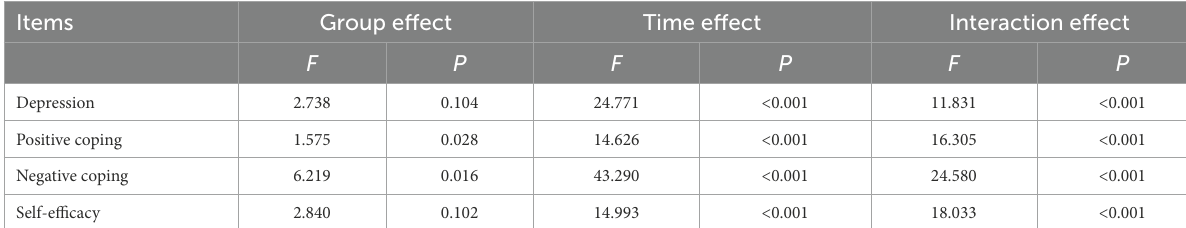
TABLE 4 Analysis of the effect of time and intervention on depression, coping ability, and